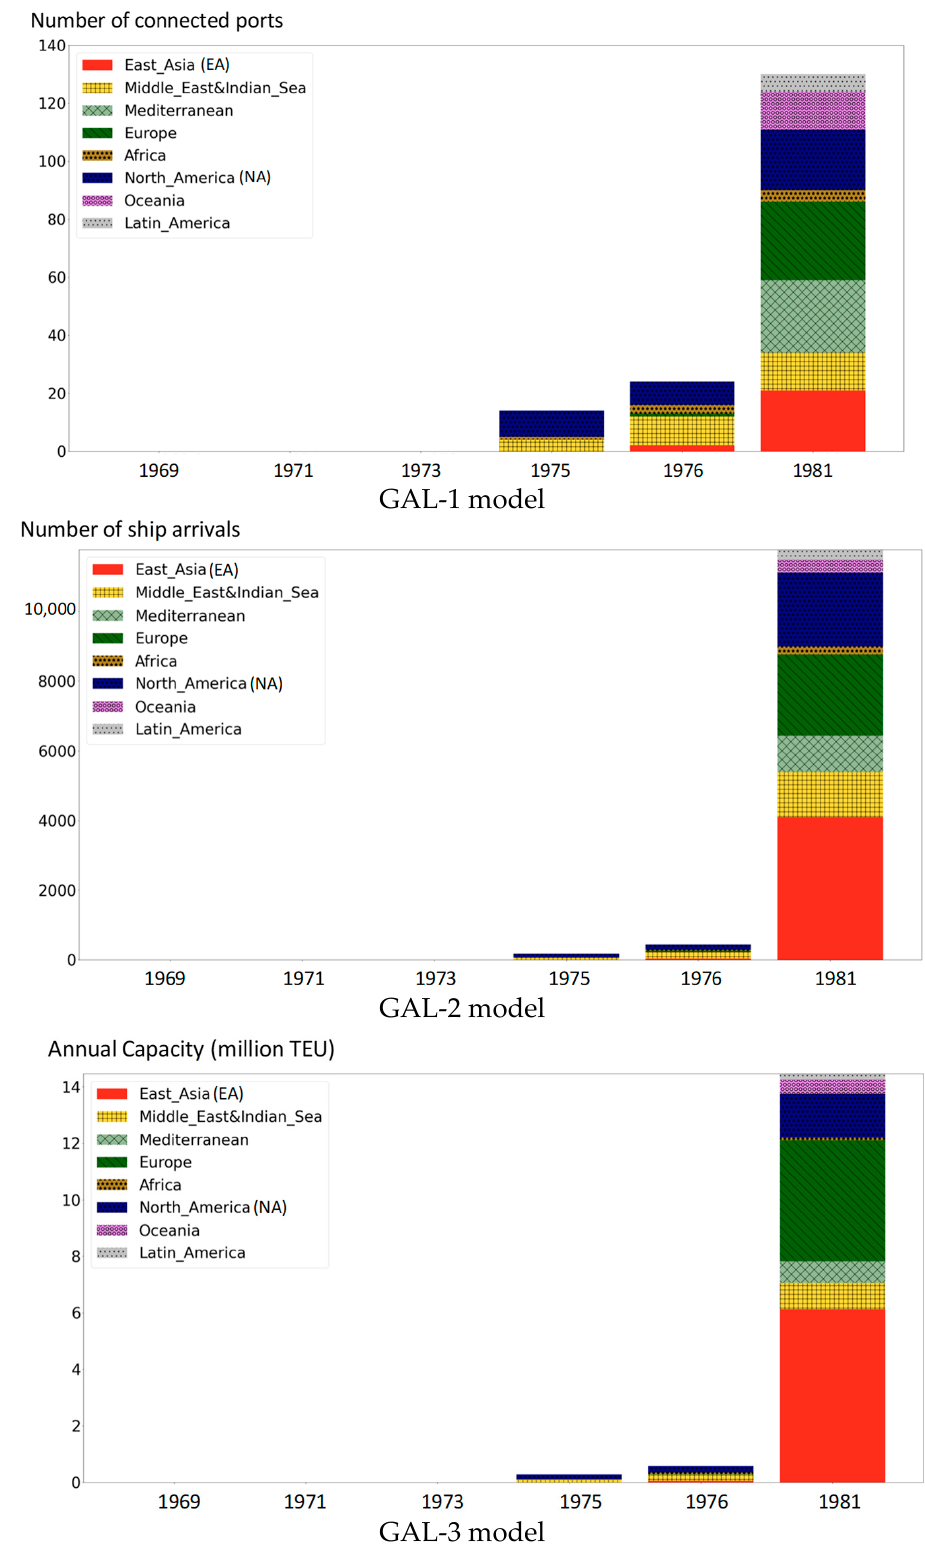
Figure 13. (Weighted) number of connected ports and regional breakdown in the port of Jeddah (1969–1981).